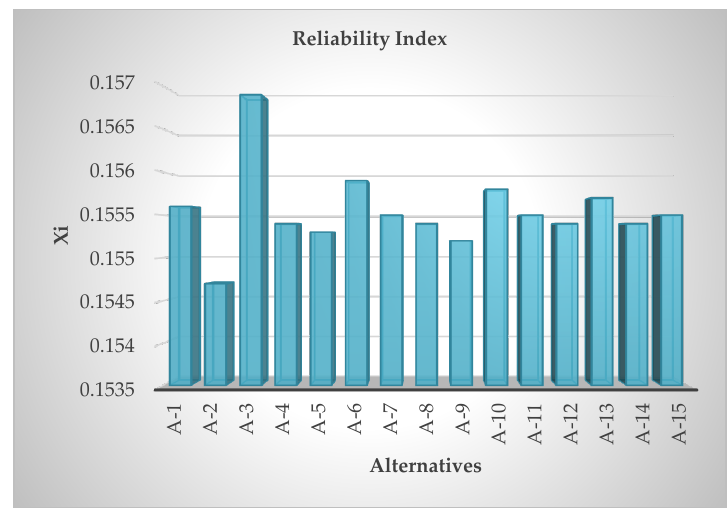
Figure 10. Reliability index of each alternative.